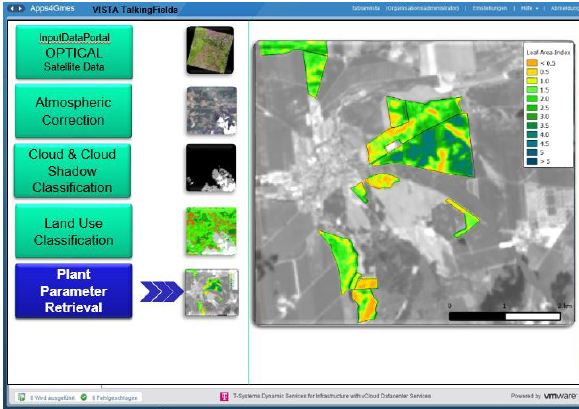
Figure 7: Processing steps performed on the generated VM All requested datasets are transformed from Vista’s proprietary binary format to GeoTIFF and a new metadata file in the OGCs EOP standard is generated for the resulting images. The results can be transferred either to the main VM for quality control or directly to the ordering party/Output Data Portal. Having all needed results at hand the processing VM is undeployed and deleted from the vCloud environment deallocating the HDD space, CPUs and